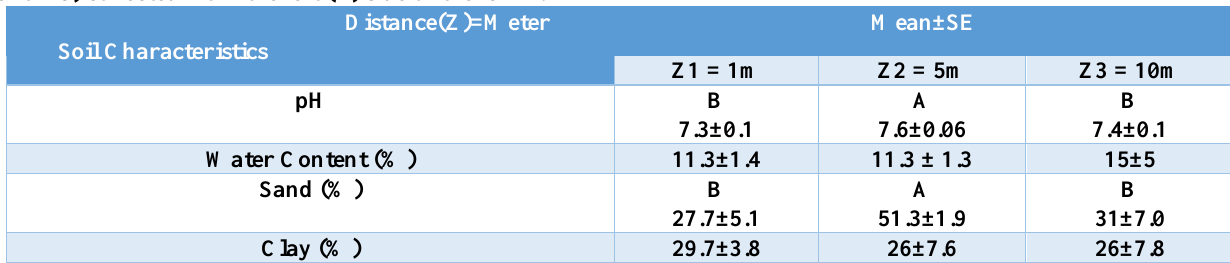
Table, 3: Comparison (mean ±SE ) of the physico-chemical characteristics of the soil at different distances (Z1,Z2, and Z3) collected from the left (L) side of the farm .